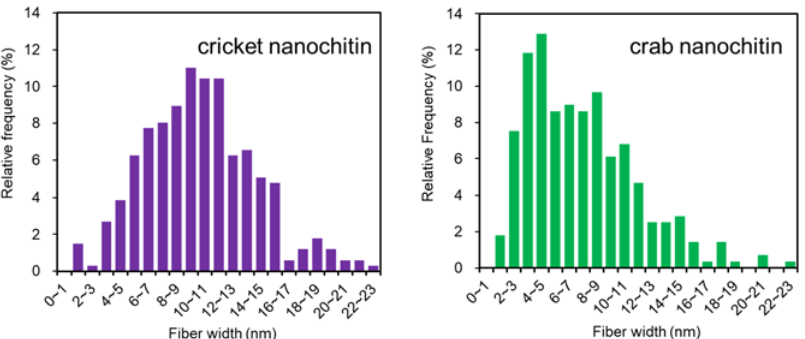
Figure 5. Distribution of length of nanochitin from ( left ) cricket and ( right ) crab shell.